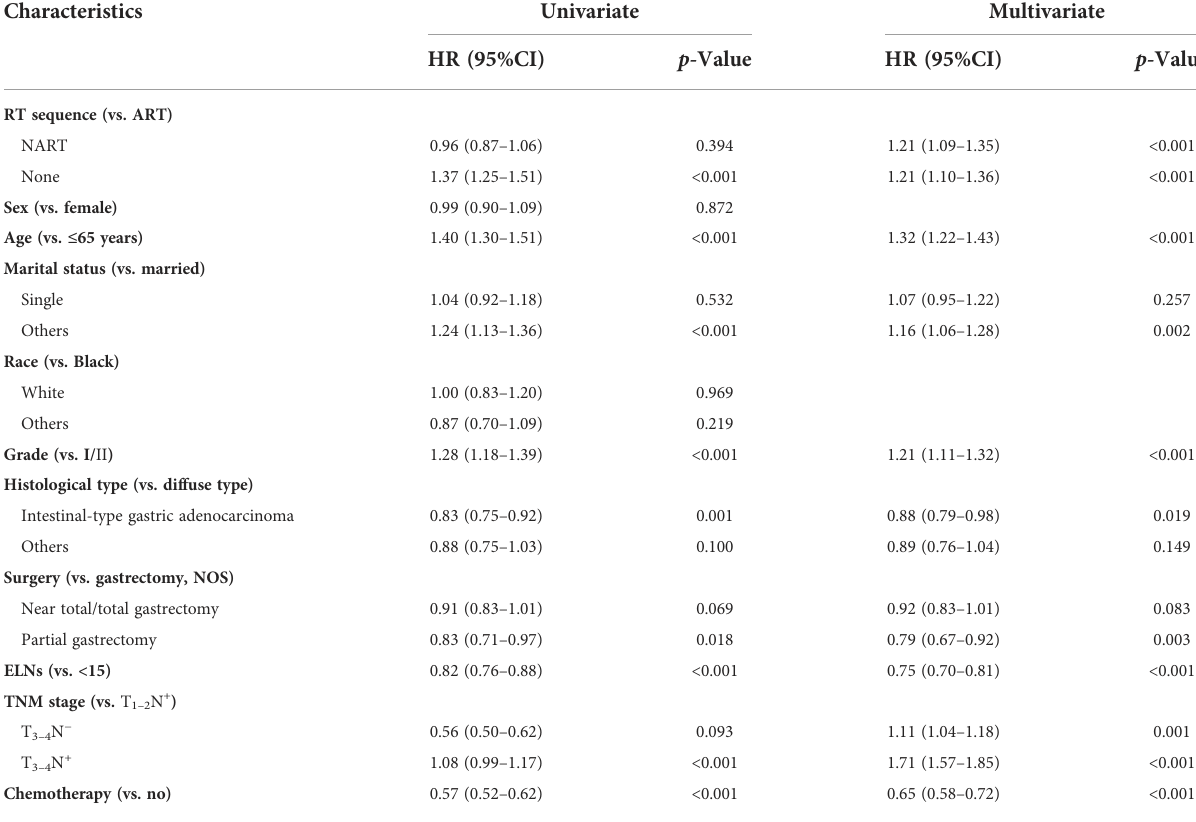
TABLE 2 Univariate and multivariate Cox regression analyses of overall survival.